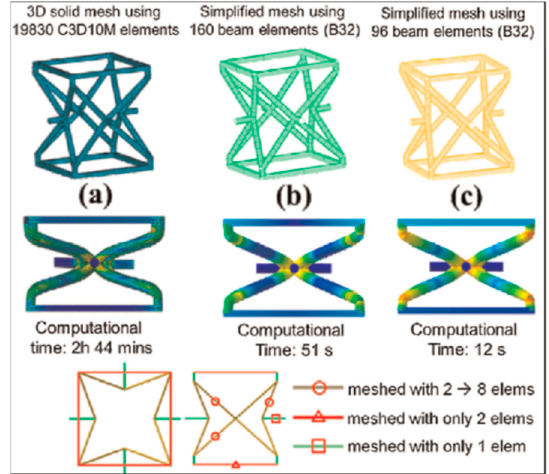
Figure 12. Modelling approaches of the 3D re-entrant cell. ( a ) 3D solid mesh using 19830 C3D10M elements, ( b ) simplified mesh using 160 beam elements, ( c ) simplified mesh using 96 beam elements [67].